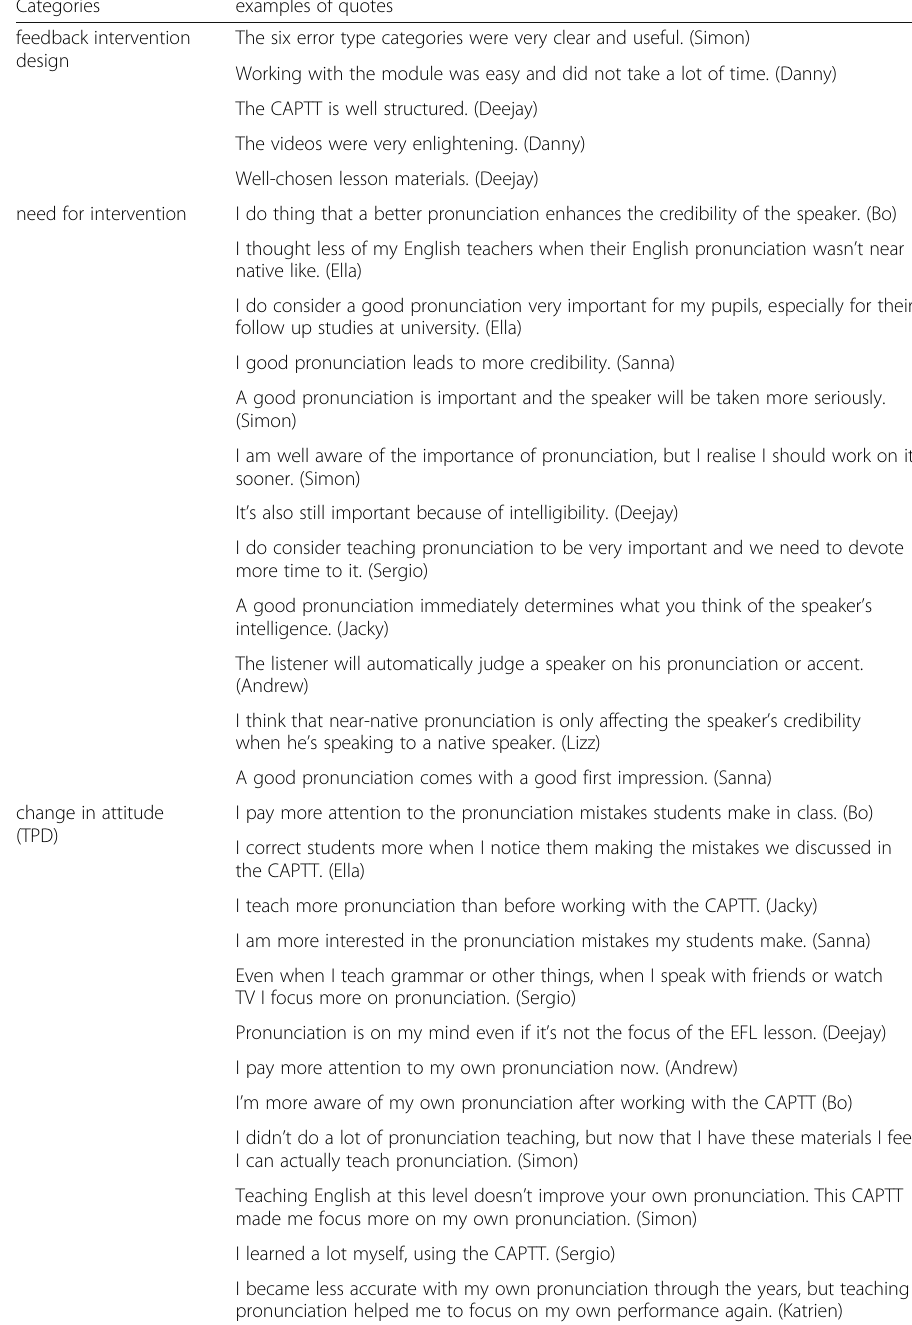
Table 5 Categories as sensitizing concepts based on research questions in test phase two Categories examples of quotes feedback intervention